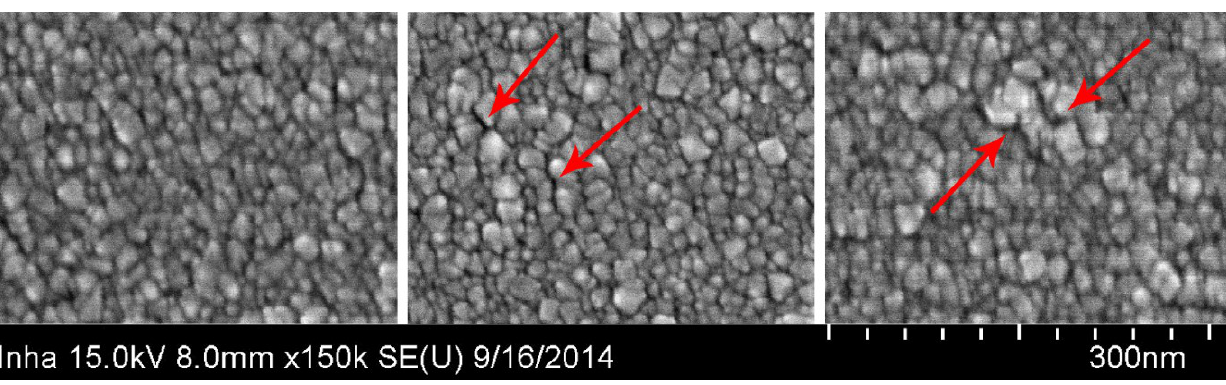
Figure 7. Comparison of the surface morphologies of ( a ) untreated; ( b ) humidity aged and ( c ) temperature aged Nafion membrane